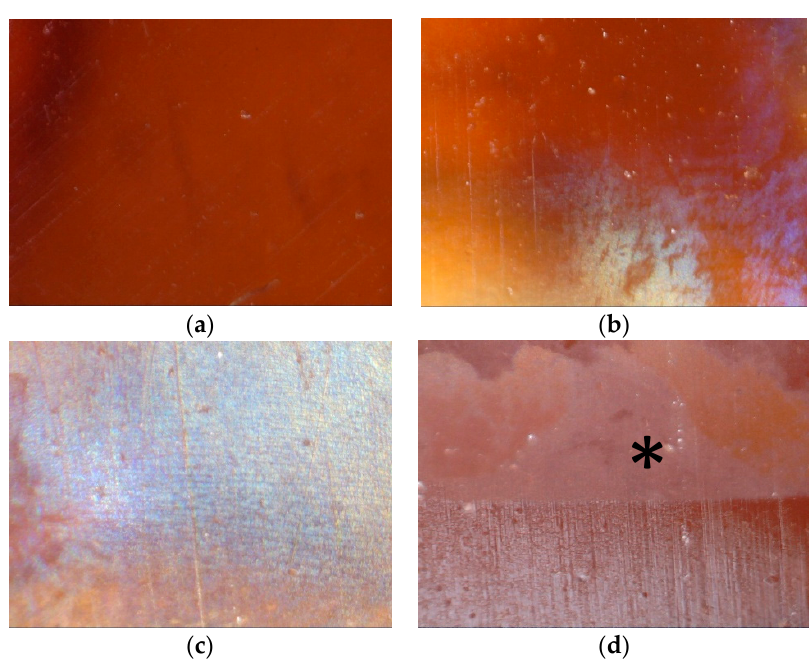
* Figure A1. Optical microphotograph (2 × 1.5 mm) of EPDM rubber after PIII: ( a ) untreated; ( b ) 5 × 10 13 ions/cm 2 PIII treated EPDM; ( c , d ) 10 14 ions/cm 2 PIII treated EPDMd ( d ) the edge of the mask (* marks the treated area).